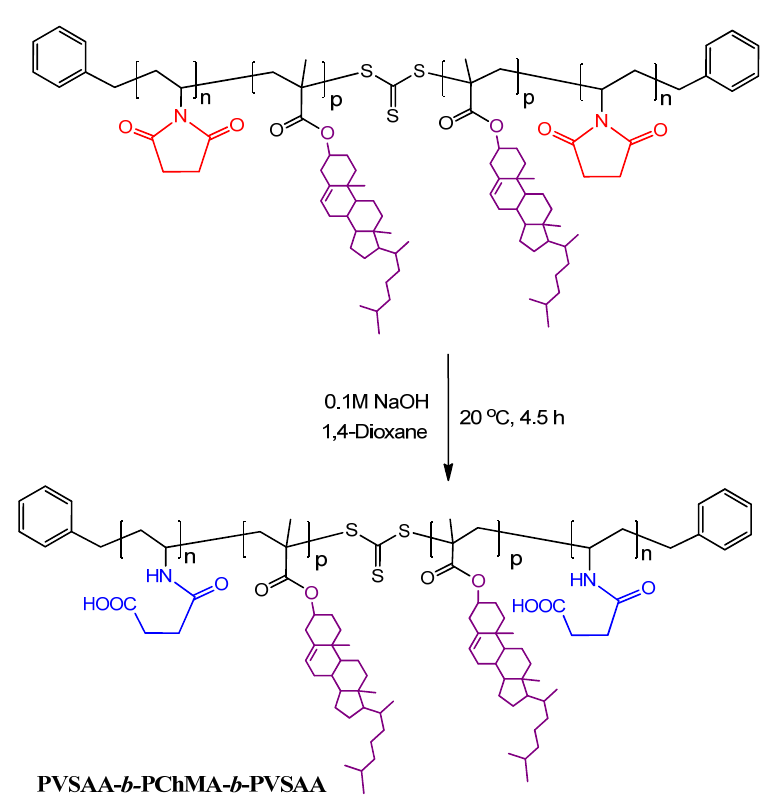
Figure 4. Scheme for PVSAA- b -PChMA- b -PVSAA preparation.